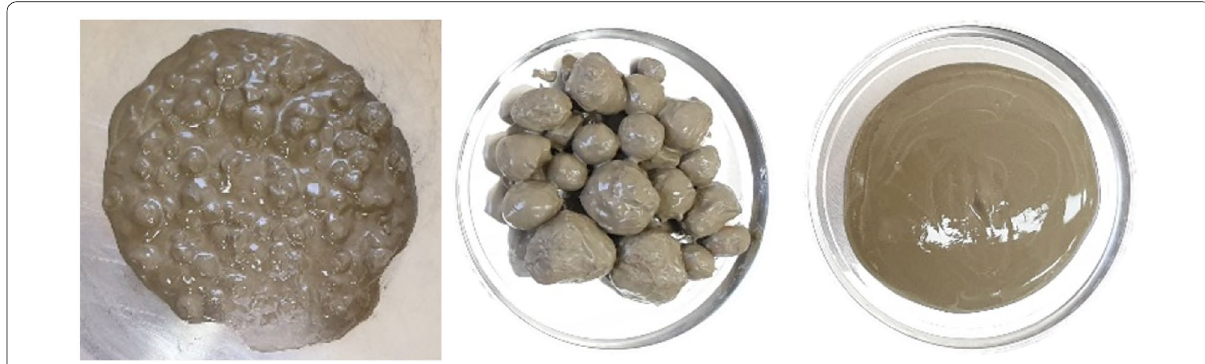
Fig. 1 LWA‑paste sample, wet‑sieved coarse LWA and wet‑sieved paste.